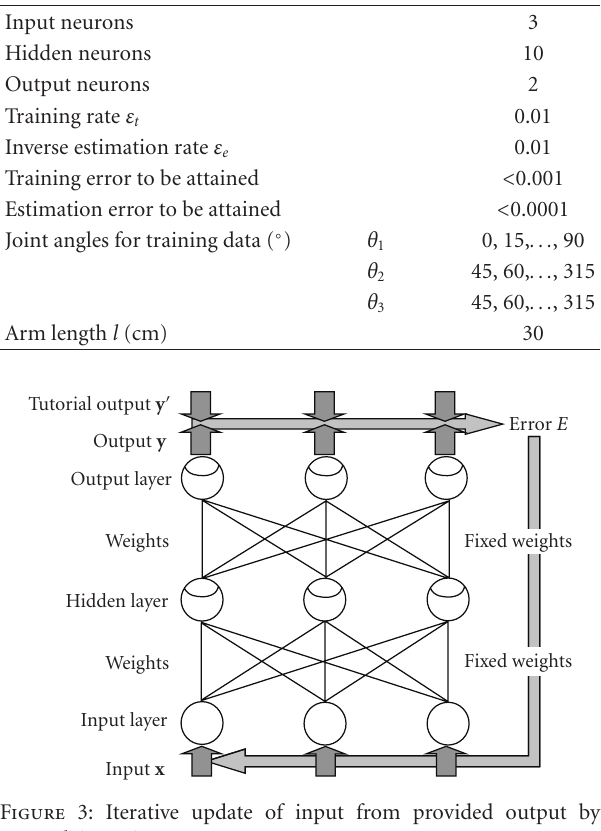
Figure 5: Network